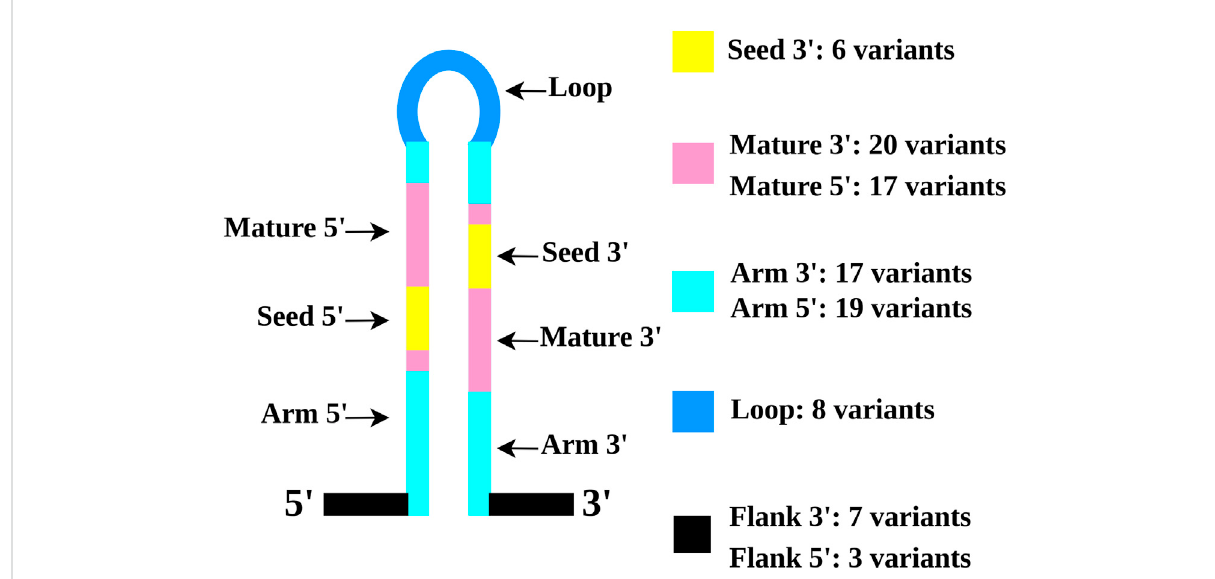
FIGURE 2 Schematic representation of ALS rare variants localization in miRNA precursors. The distinct miRNA regions are indicated by speci fi c colors: seed (yellow), mature (pink), arms (light blue), loops (blue), and fl anking region